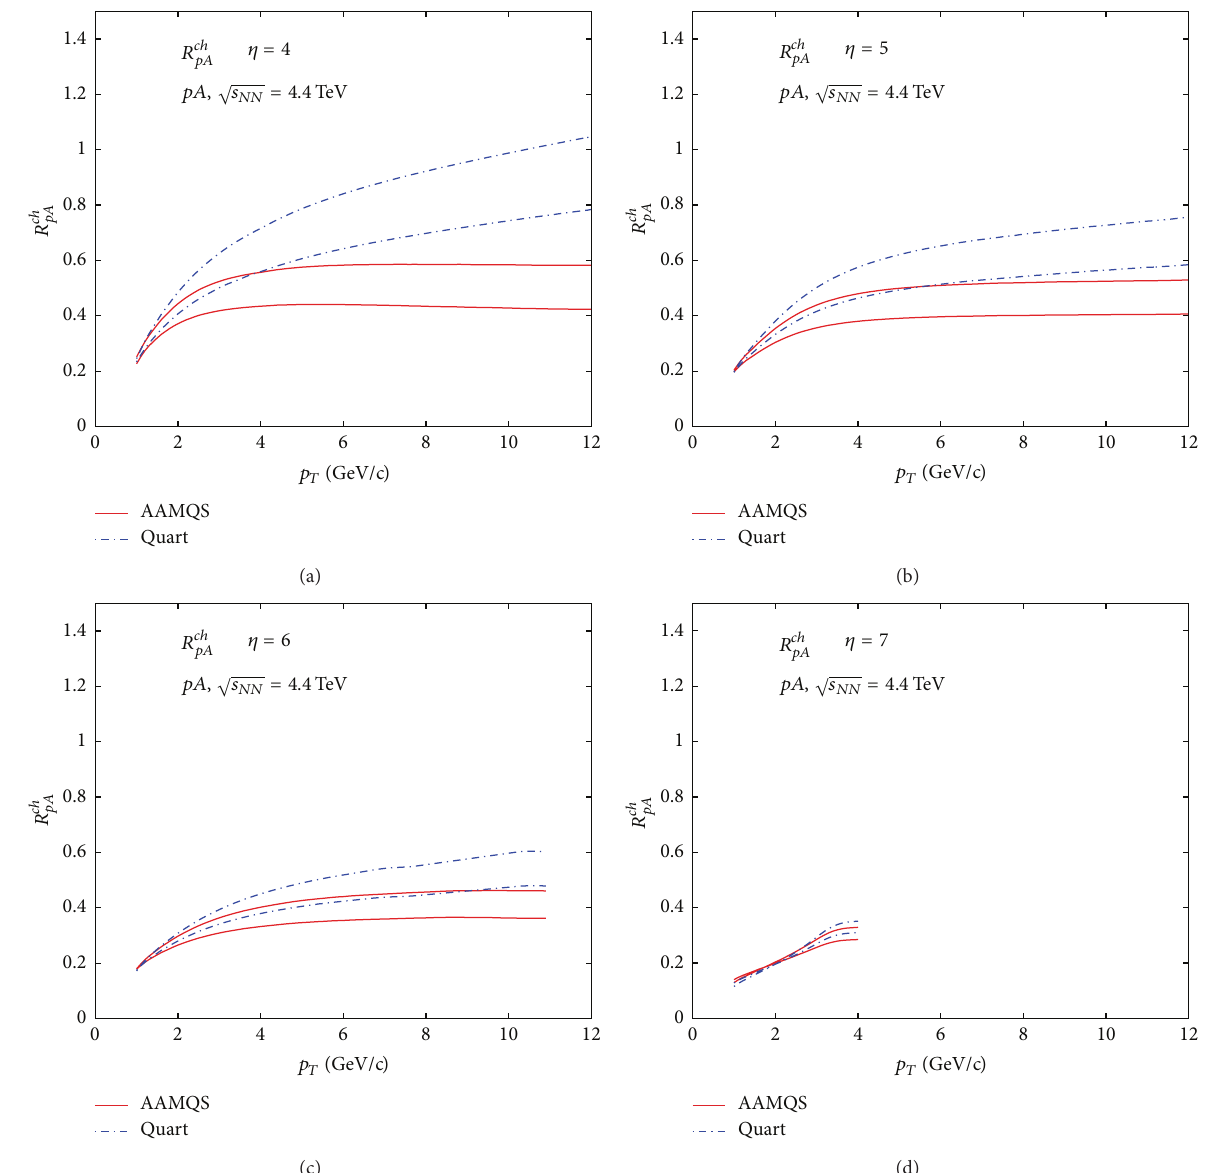
Figure 8: Nuclear modification factor 𝑅 𝑐ℎ 𝑝𝐴 versus 𝑝 𝑇 for inclusive charged hadrons ℎ + + ℎ − production in minimum-bias 𝑝+ Pb collisions at = 4.4 TeV with different 𝜂 . The double solid curves and the double dashed-dotted curves are calculated, respectively, by the AAMQS √𝑠 𝑁𝑁 and quartic action, which represents the uncertainty ranges in 𝑅 𝑐ℎ 𝑝𝐴 when 𝑄 2 0𝑠 = 0.5 to 0.67 GeV 2